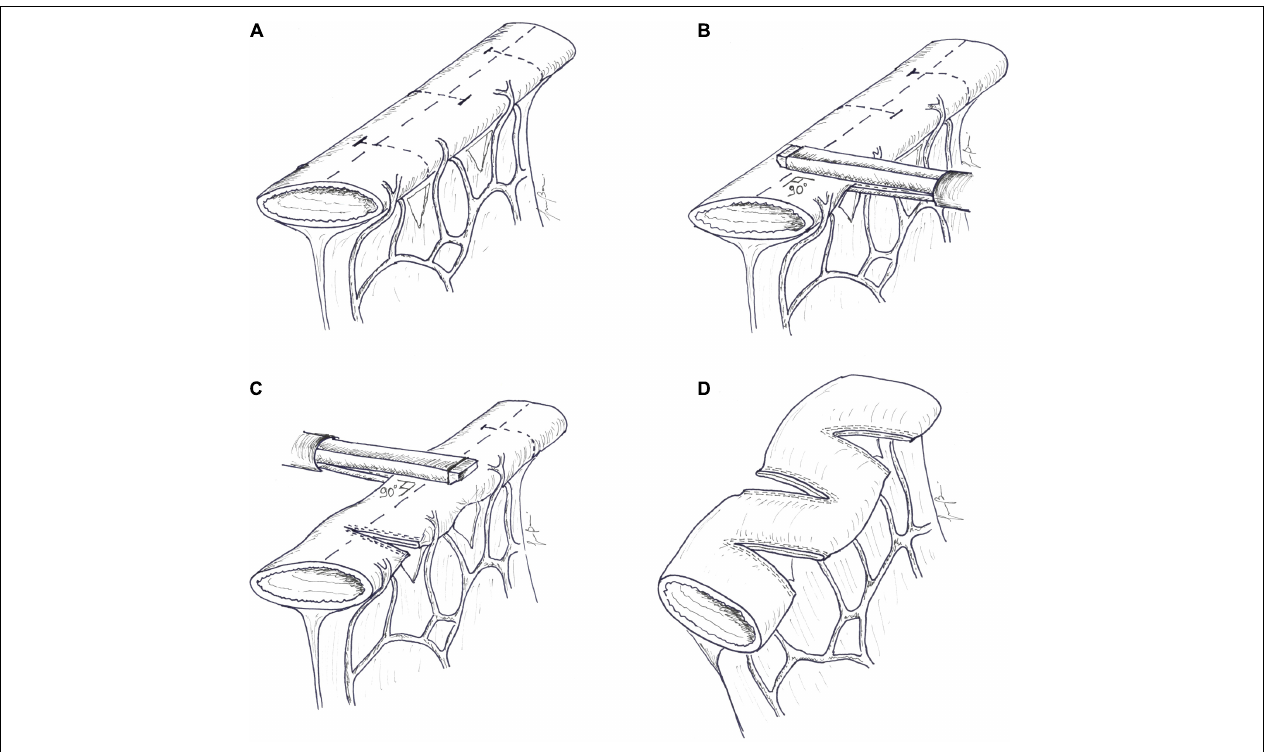
FIGURE 5 | Serial transverse enteroplasty (STEP). (A) A marker line is drawn longitudinally along the midline, in the antimesenteric border of the dilated segment of the bowel, as an orientation guide. A small defect is created in the mesentery. (B) The larger side of an endoscopic GIA stapler is inserted perpendicular to the long axis of the bowel. The bowel is flattened, keeping the antimesenteric marker line strictly in the midline, and the stapler is applied; (C) The next cut is taken distally to the previous cut, and the stapler is now inserted from the opposite side. The procedure is carried on serially, until all the dilated bowel has been treated. (D) The final result is a zig-zag lengthened bowel. Channel size, usually about 2 cm, is determined by the length of the staple-line and the distance between stapler